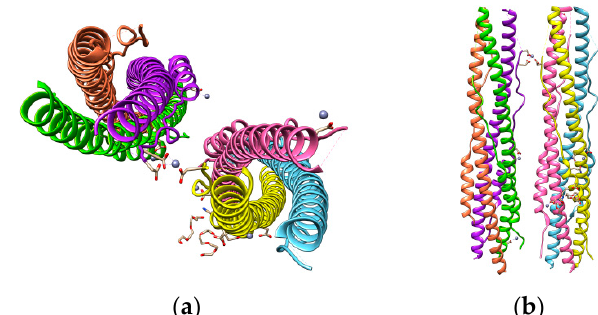
Figure 6. SARS-CoV-2 S protein HR1 and HR2 domains ( a ) and their parallel-antiparallel view ( b ). HR1 helices are colored in yellow, hot pink, and sky blue and those of HR2 in coral, purple, and